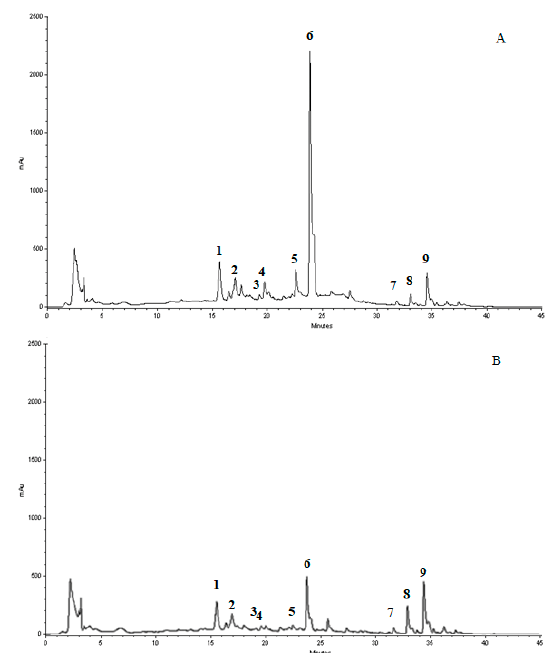
Figure 1. Reverse phase-diode array detector-high performance liquid chromatography (RP-HPLC-DAD) separation of the compounds present in the lyophilized powder registered at 280 ( A ) and 325 nm ( B ). Vicenin-2 (1), lucenin-2 4 (cid:48) -methyl ether (2), orientin4 (cid:48) methylether (3), eriocitrin (4), narirutin (5), hesperidin (6), sinensetin (7), tangeretin (8), nobiletin (9). Peak identification was performed by matching retention time and UV spectra against commercially available reference compounds and spiking the samples with pure reference